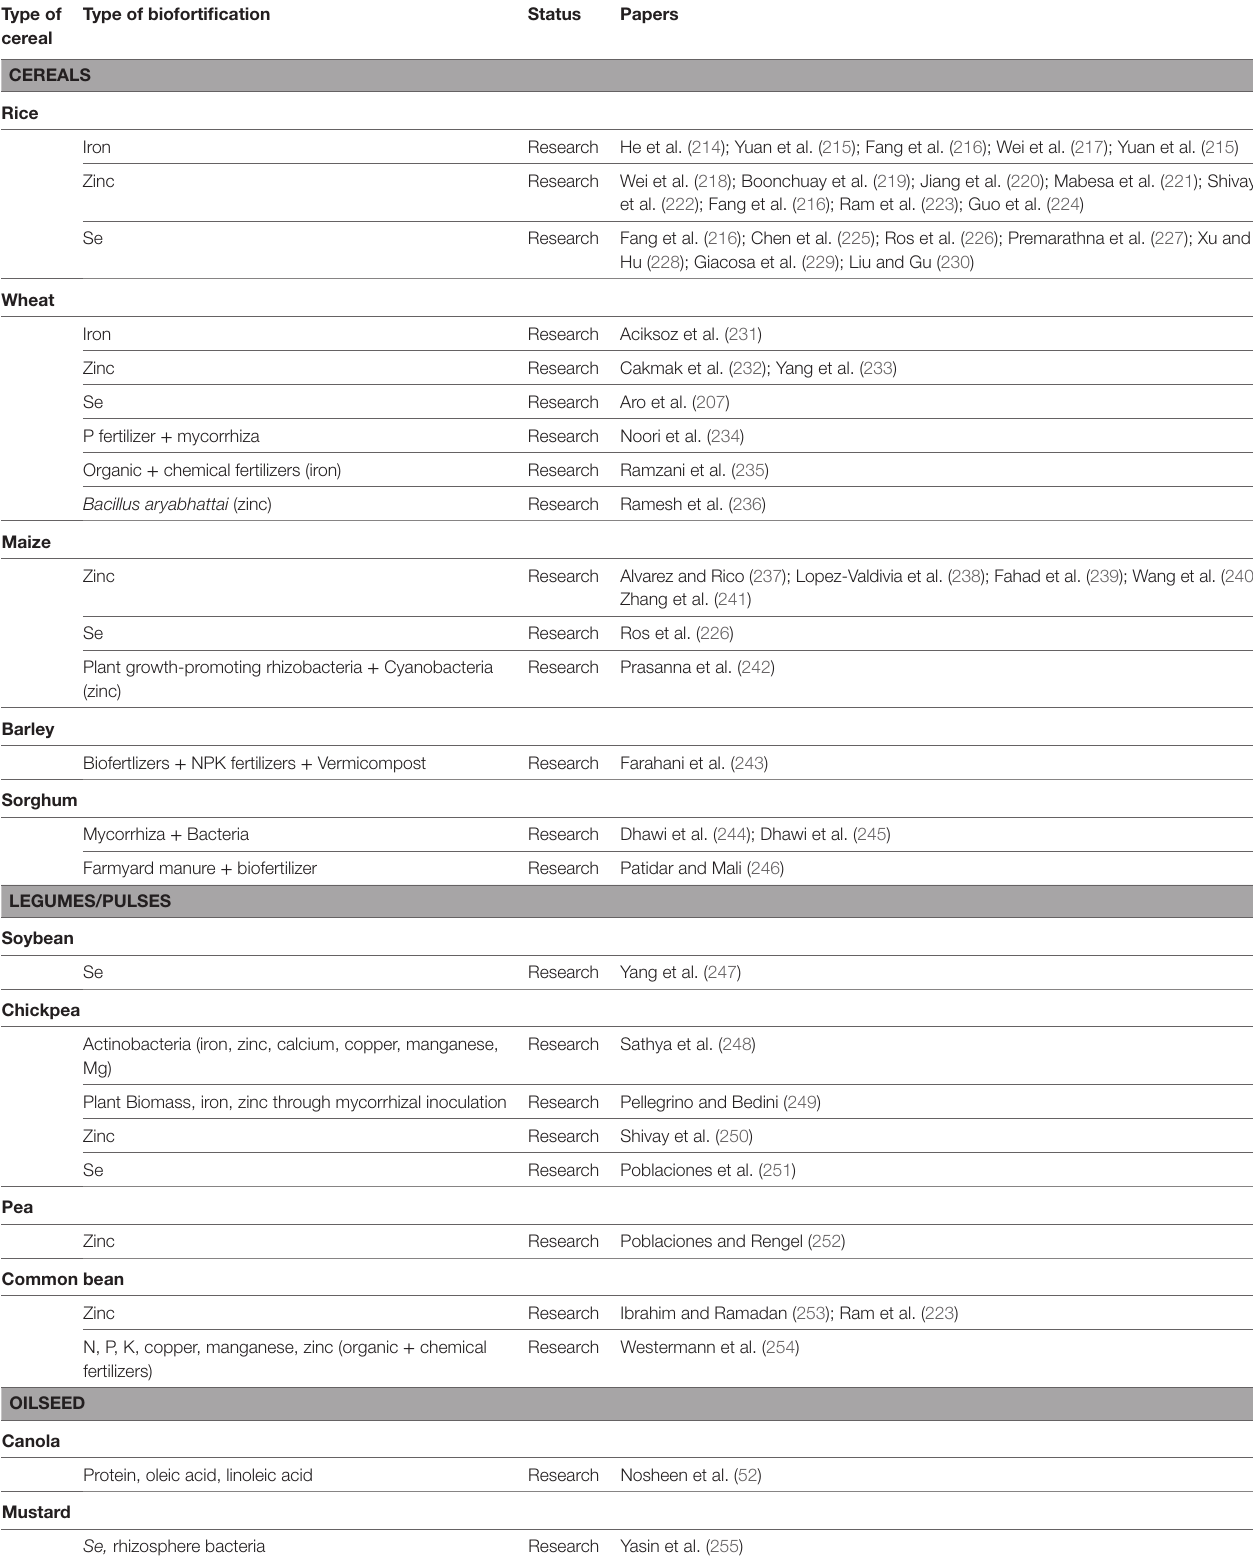
TABLe 3 | Tabulation of crops, nutrients, research status, and concerned publications on biofortification through agronomic